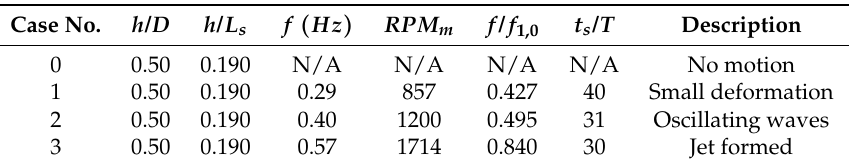
Table 1. Sloshing test